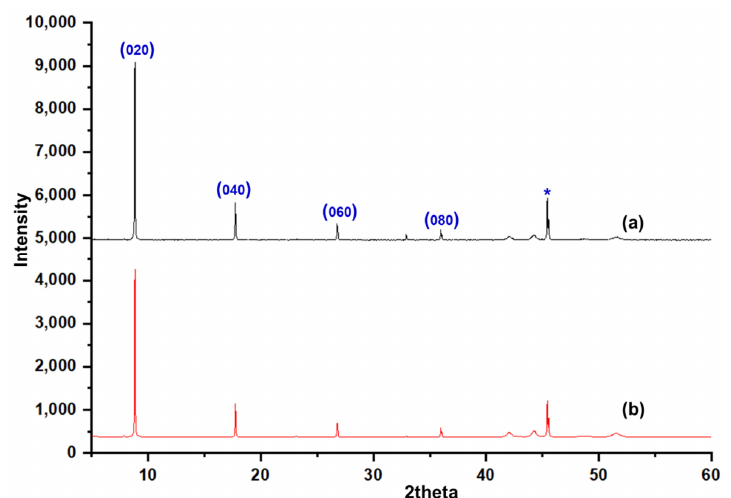
Figure 4. SEM image of seed silicalite-1 on silicon substrate at varying colloidal seed concentrations and number of dip coating ( a – d ). The 1 wt% seed silicalite-1, 1 wt% CTAB and 20 mL ETOH with coating for 1, 3, 5 and 7 times ( e – h ). The 4 wt% seed silicalite-1, 1 wt% CTAB and 20 mL ETOH with coating for 1, 3, 5 and 7 times ( i – l ). The 4 wt% seed silicalite-1 and 20 mL ETOH with coating for 3, 5, 7 and 9 times, respectively.